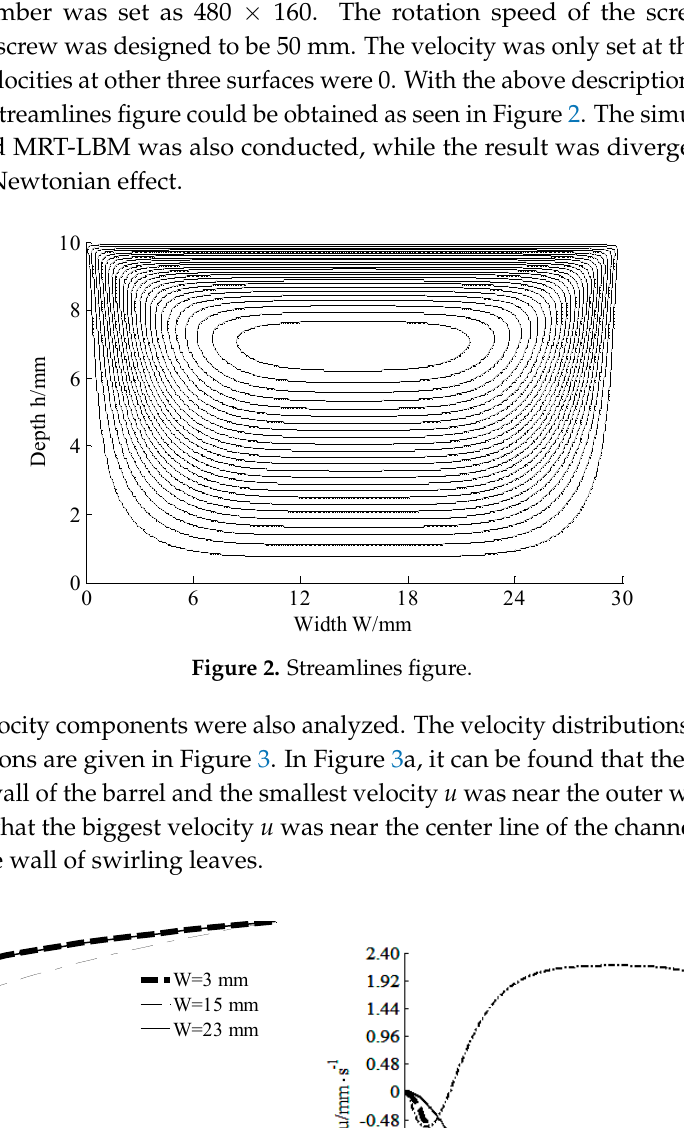
Table 1. The key parameters of the extruder.